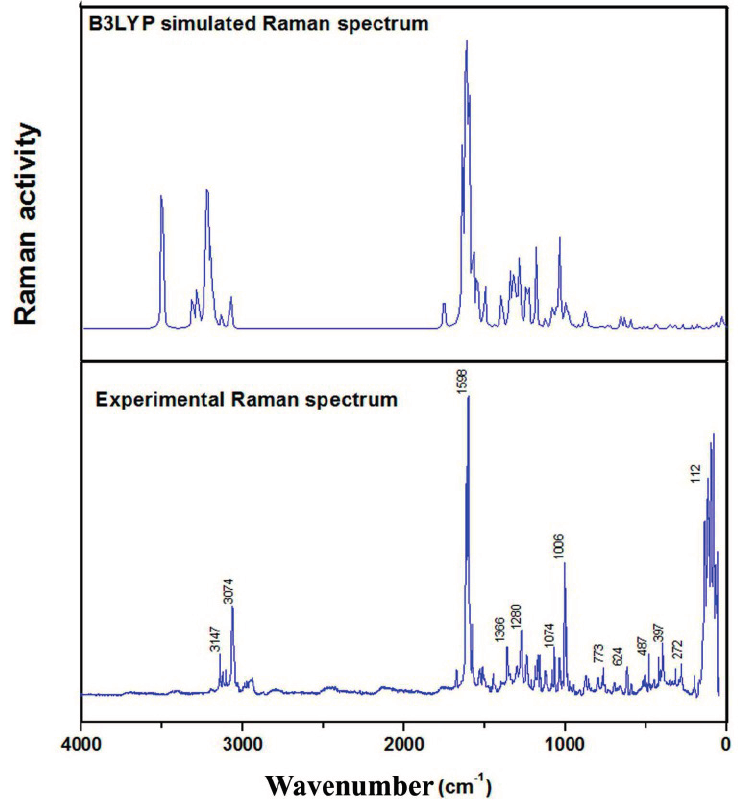
Figure 8. Theoretical (B3LYP) and experimental Raman spectra of (2 E